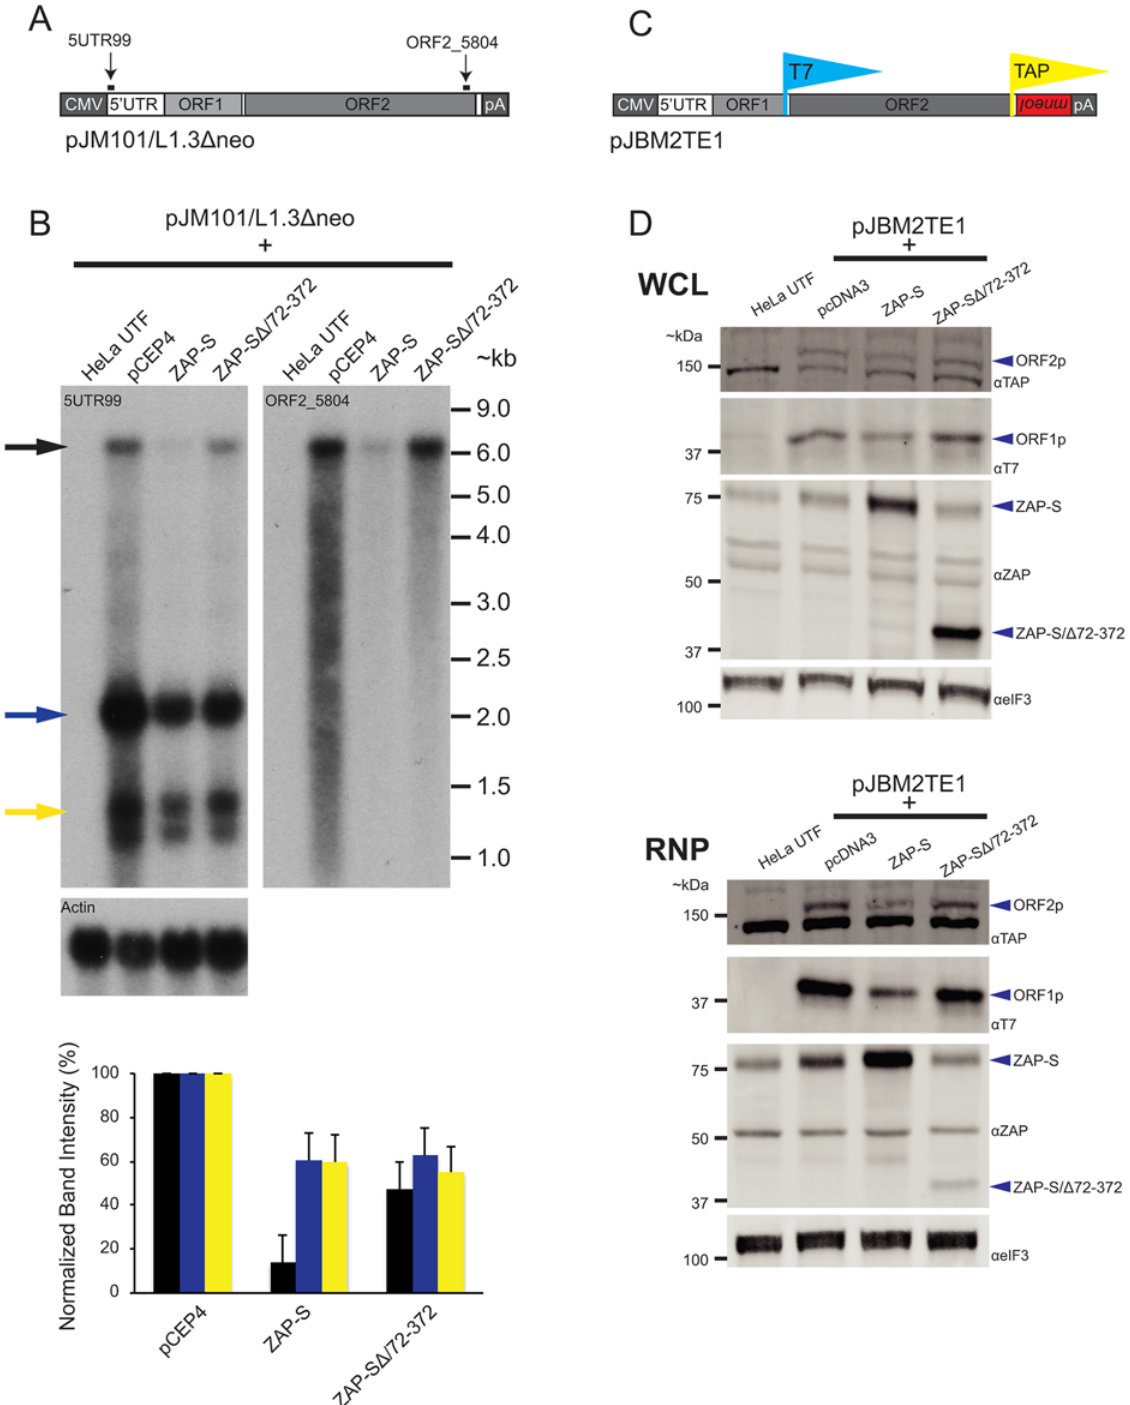
Fig 4. The effect of ZAP-S on L1 RNA and L1 protein expression. (A) Schematic of pJM101/L1 . 3 Δ neo : Bold black lines indicate the approximate location of probes (5UTR99 and ORF2_5804) used in the northern blot experiments. pJM101/L1.3 Δ neo is expressed from a pCEP4 vector. A CMV promoter augments L1 expression and an SV40 polyadenylation signal (pA) is located downstream of the native L1 polyadenylation signal. (B) Results of northern blots : Top panel: HeLa cells were co-transfected with pJM101/L1.3 Δ neo and either the indicated ZAP-S expression plasmids or an empty pCEP4 vector. Northern blot images depict the effect of ZAP-S overexpression on polyadenylated L1 RNA levels. The constructs transfected into HeLa cells are indicated above each lane. UTF indicates untransfected HeLa cells and serves as a negative control. Probes (5UTR99 and ORF2_5804) are indicated in the top